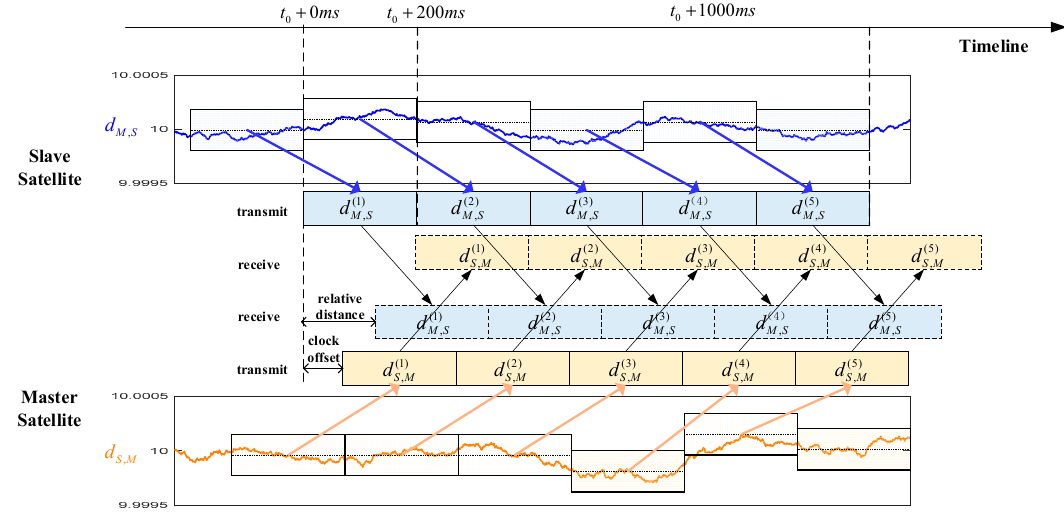
Figure 11. Measured distance exchanging model.